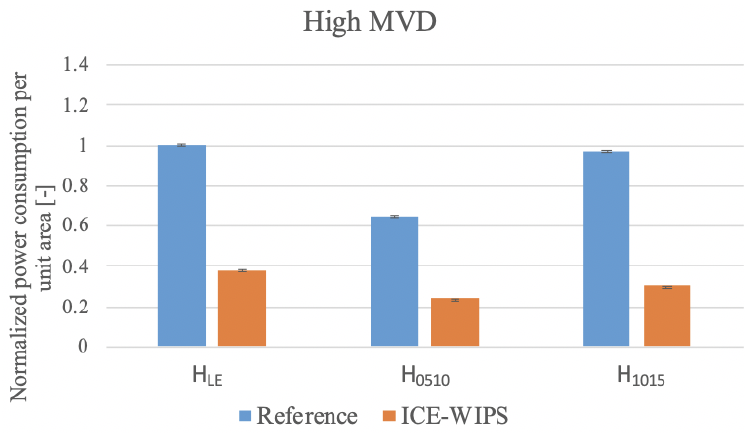
Figure 12. Normalized power consumption per unit area of each heating area for High MVD case.